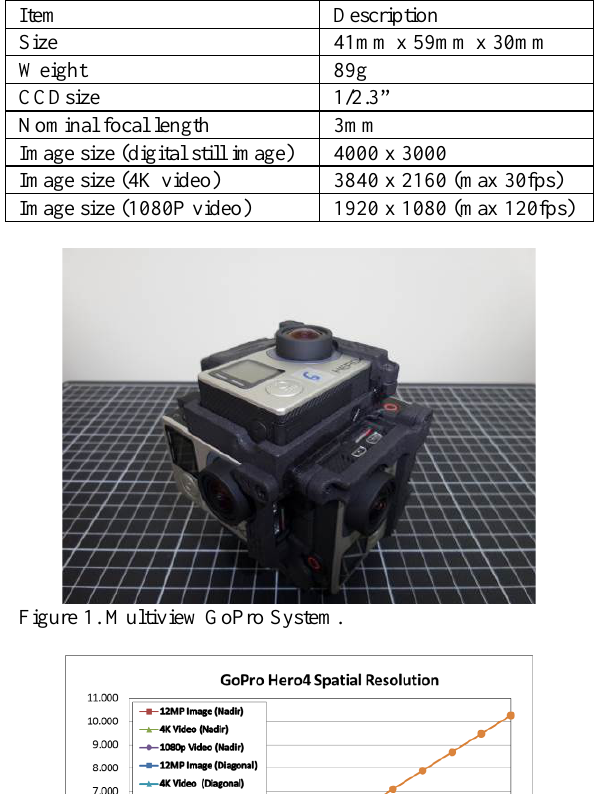
Table 1. Related parameters for GoPro Hero Black